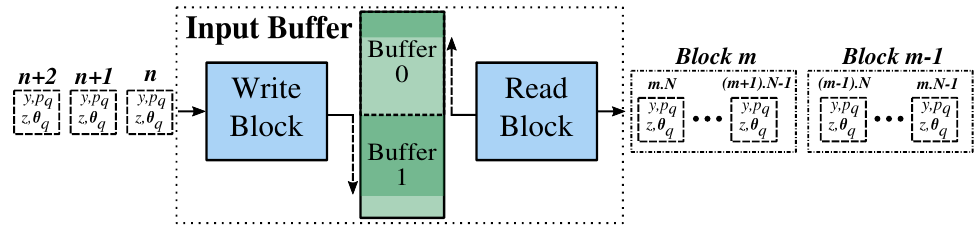
Figure 6. Input Buffer block diagram, showing its operation for block size N.